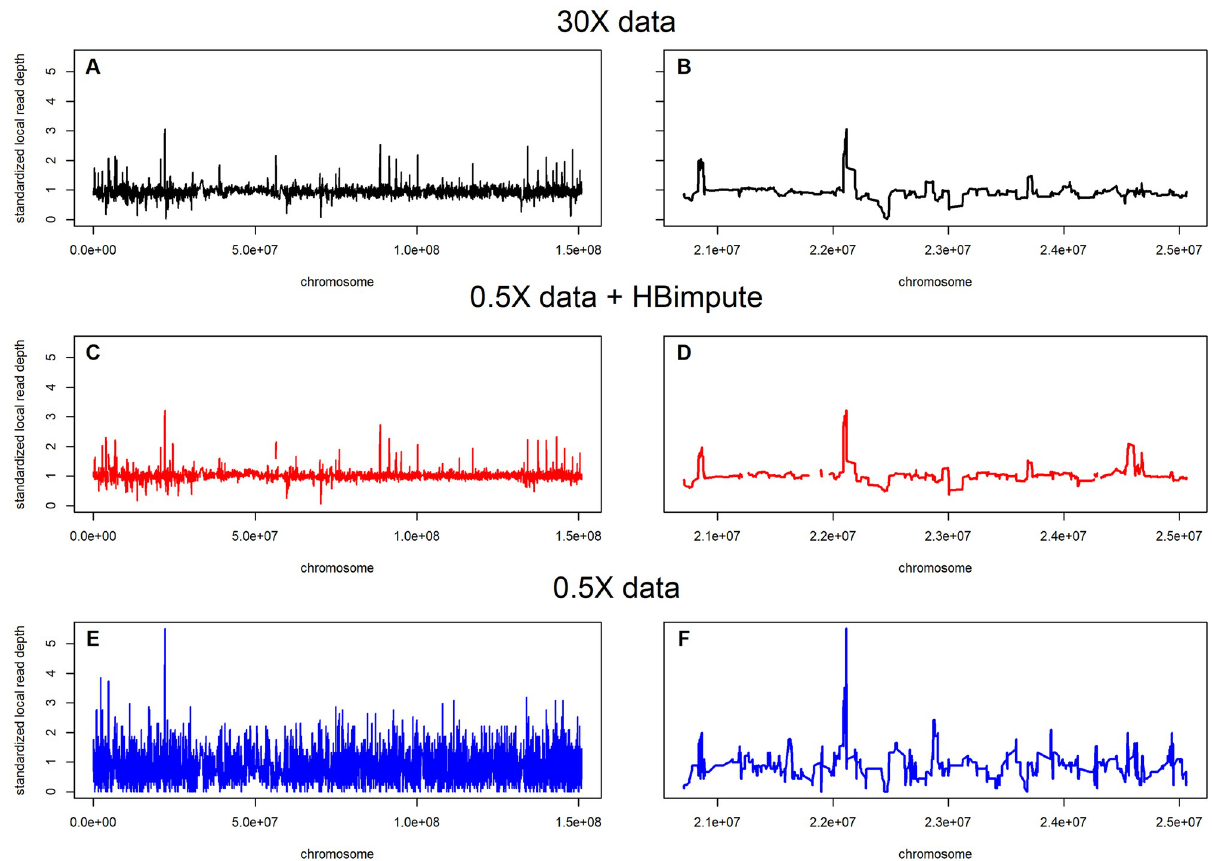
Fig 4. Estimated standardized read-depth for line PE0213 via the use of high read-depth sequence data (A/B), imputed low read-depth sequence data via HBimpute (C/D) and raw low depth depth sequence data (E/F) for chromosome 10 (A/C/E) and an exemplary chosen segment in a peak region